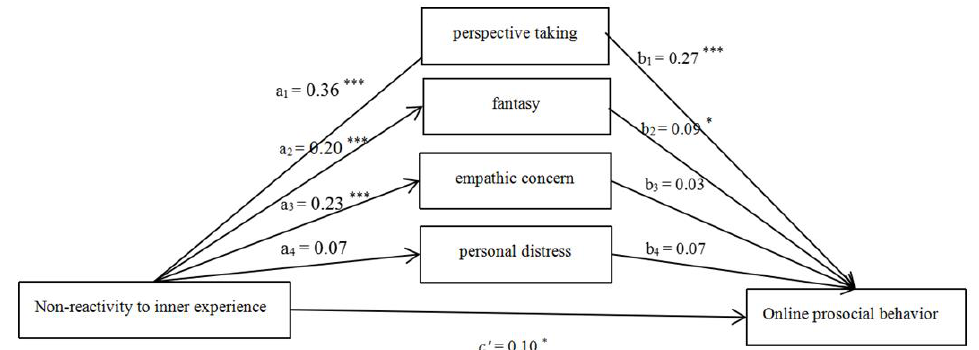
Figure 5. Mediating roles of empathy components (Non-reactivity as the predictor). Note: * p < 0.05, *** p < 0.001.